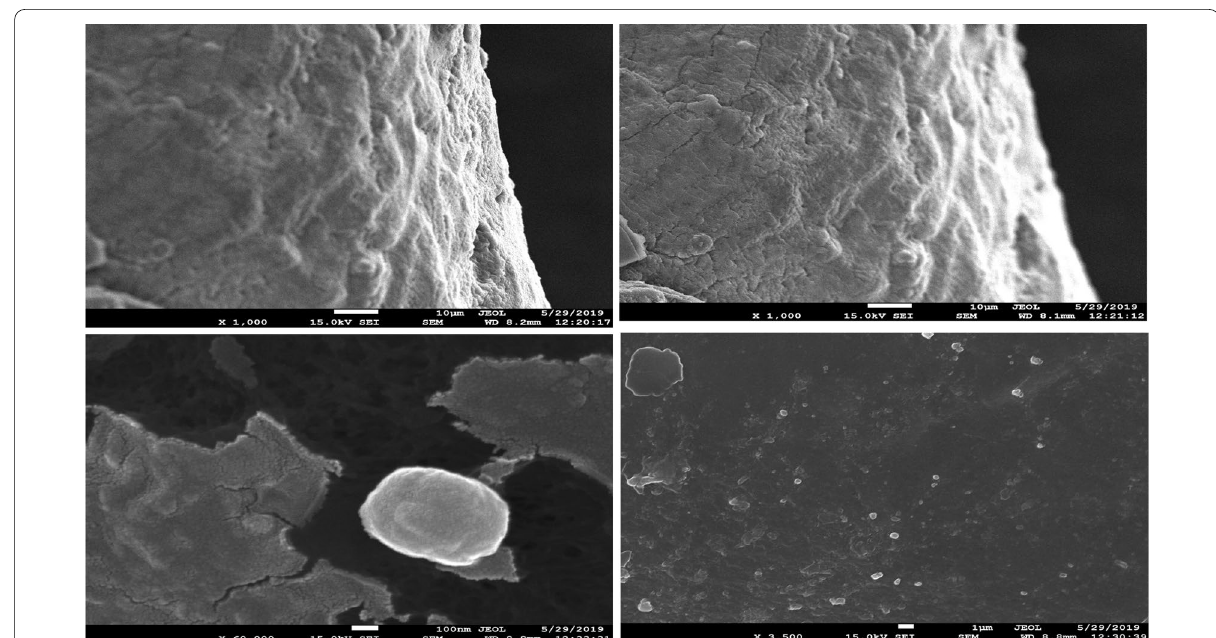
Fig. 5 FESEM photographs of the surface of the prepared mucoadhesive microsphere loaded with gliclazide. The image indicated smooth surface with occasional wrinkles and presence of polymeric